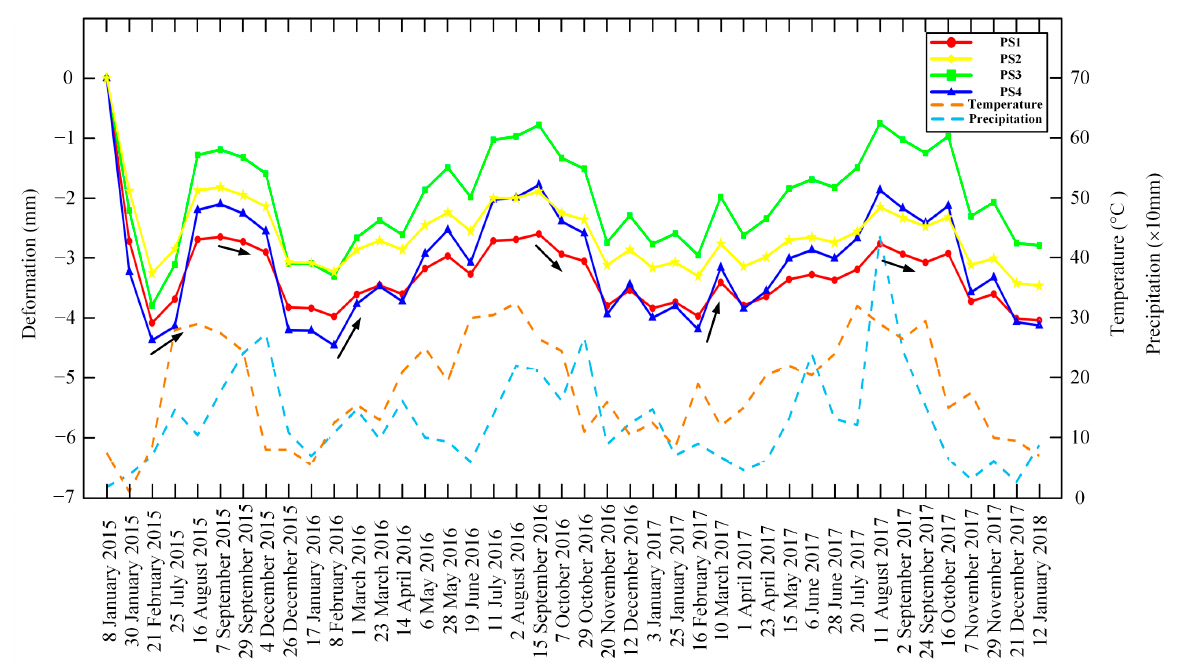
Figure 13. Three years of time-series deformations at the feature points.